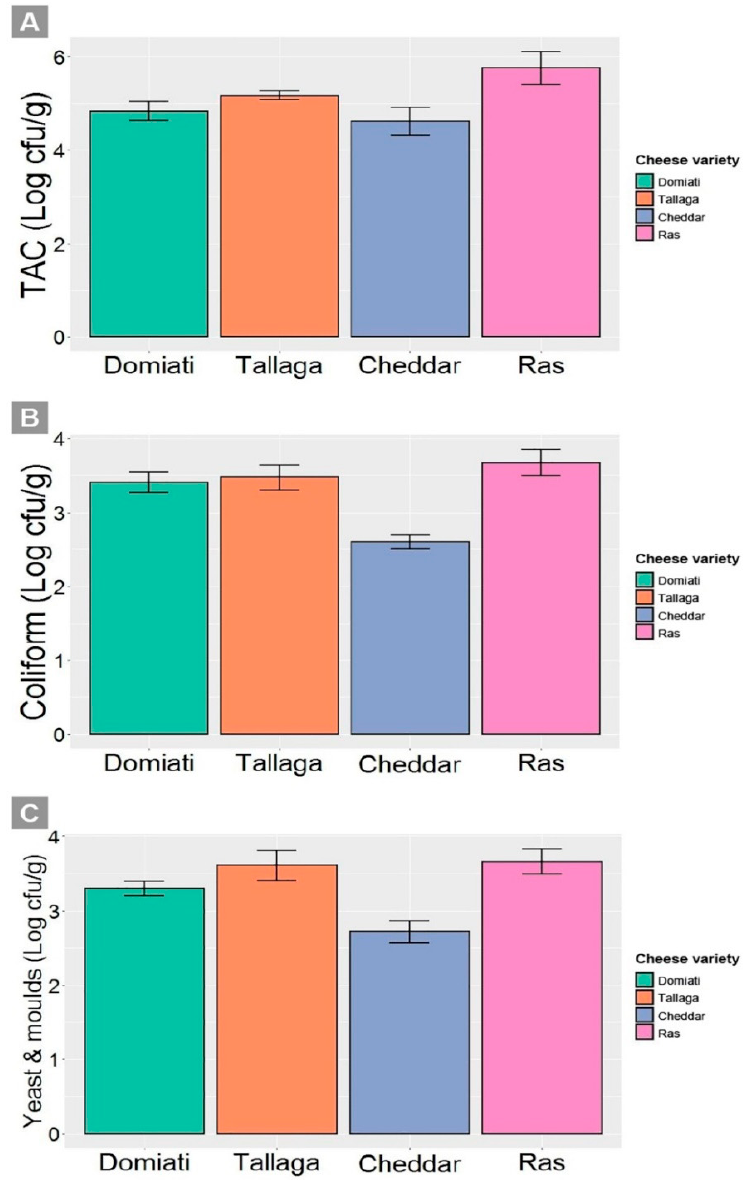
Figure 4. Bar plot of microbiological quality of the investigated cheese samples (Total aerobic count ( A ), Coliform count ( B ) and Yeast & moulds count ( C )). Data expressed as mean ± SE ( n = 15).